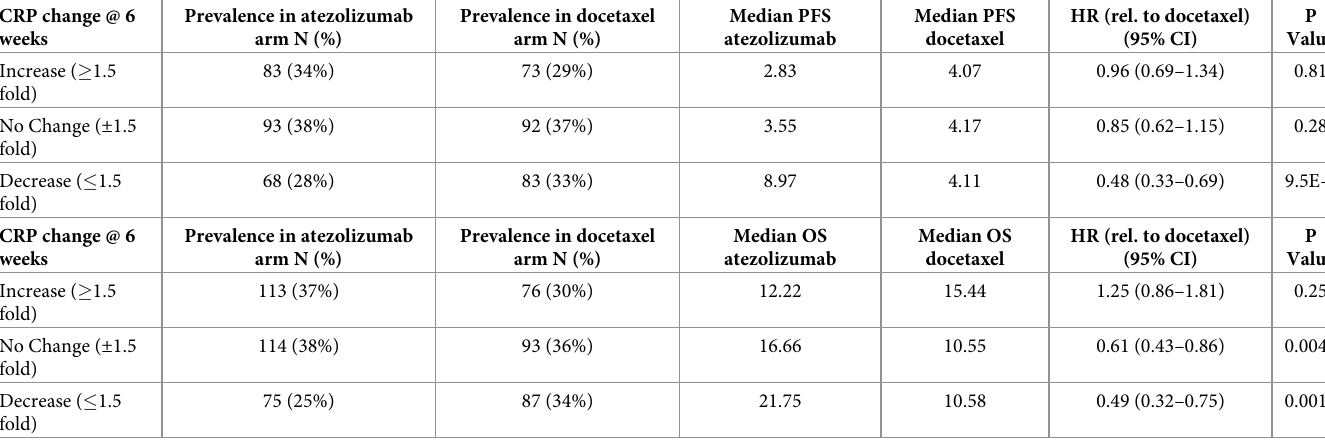
Table 1. PFS and OS benefit based on CRP changes at 6 weeks in